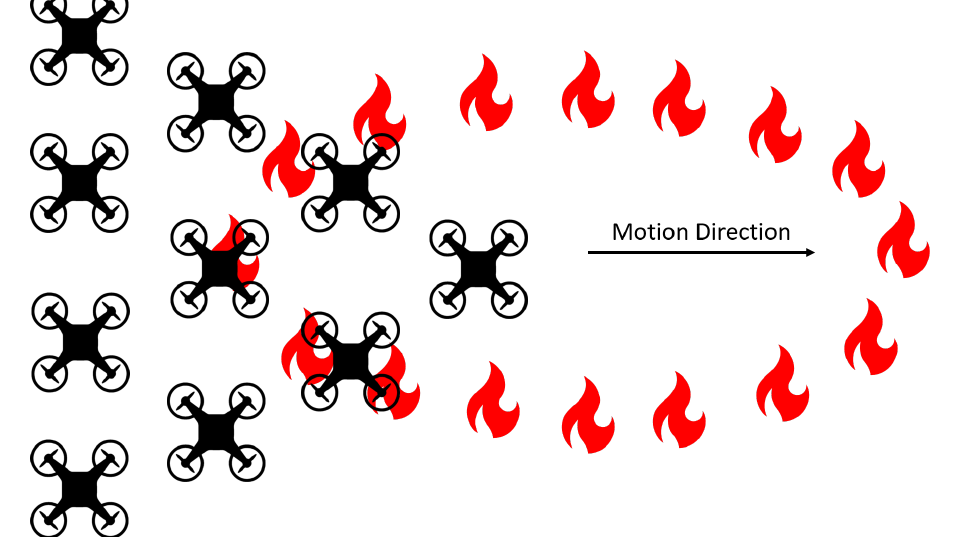
Figure 3. Action in arrow formation in front of a fire with an elliptical shape.